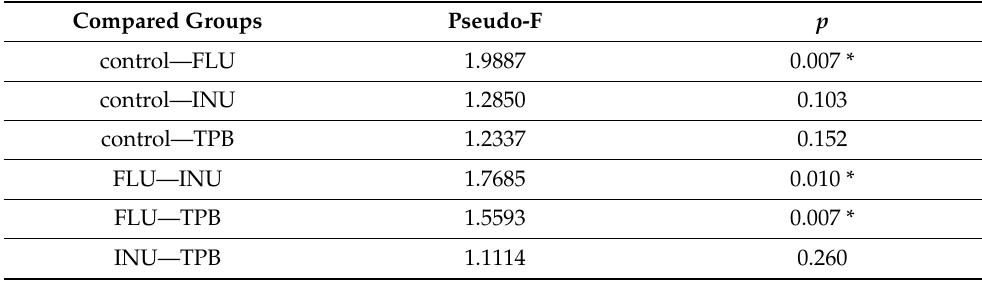
Figure 10. Principal–coordinate analysis (PCoA) showing a two–dimensional ordination of tested microbiota profiles grouped according to the treatment. Table 1. Results of pairwise PERMANOVA.